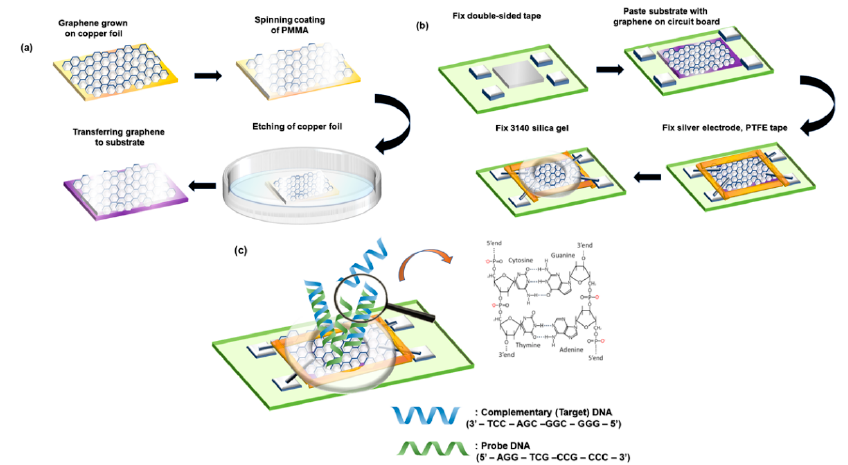
Figure 1. ( a ) Graphene transfer process; ( b ) Hall e ff ect device fabrication process; ( c ) DNA hybridization on